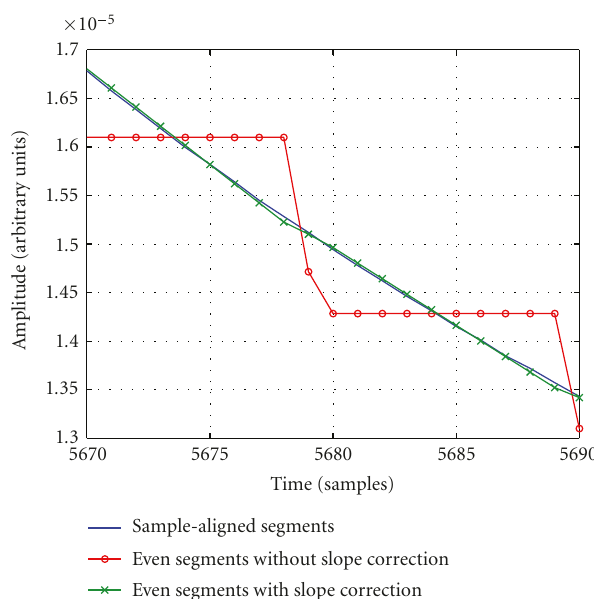
Figure 3: Multi-sample distribution for evenly sized segments with and without the slope correction, which assumes the impulse re- sponse has a locally linear